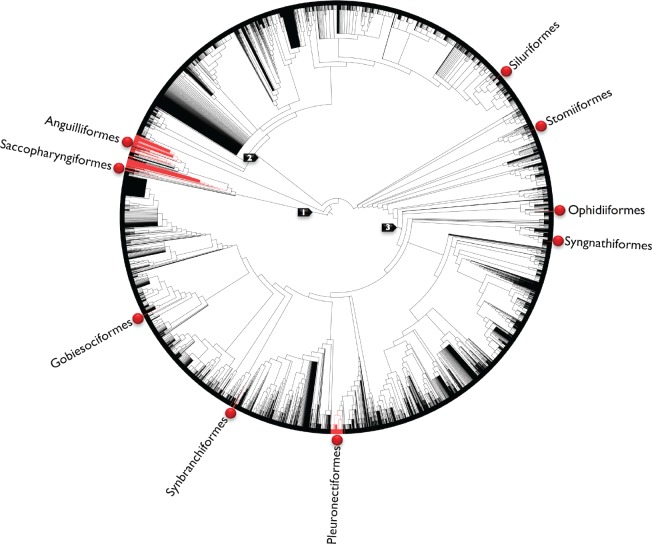
Visualization of pectoral fin presence (black) and absence (red) across 38,419 species of teleost fishes using an unordered parsimony method of reconstruction requiring 27 steps. Fin loss is evident in nine orders (red balls). Arrows indicate higher-level groupings: 1 \documentclass[12pt]{minimal}
\usepackage{amsmath}
\usepackage{wasysym}
\usepackage{amsfonts}
\usepackage{amssymb}
\usepackage{amsbsy}
\usepackage{upgreek}
\usepackage{mathrsfs}
\setlength{\oddsidemargin}{-69pt}
\begin{document}
}{}$=$\end{document} Elopomorpha; 2 \documentclass[12pt]{minimal}
\usepackage{amsmath}
\usepackage{wasysym}
\usepackage{amsfonts}
\usepackage{amssymb}
\usepackage{amsbsy}
\usepackage{upgreek}
\usepackage{mathrsfs}
\setlength{\oddsidemargin}{-69pt}
\begin{document}
}{}$=$\end{document} Otomorpha; 3 \documentclass[12pt]{minimal}
\usepackage{amsmath}
\usepackage{wasysym}
\usepackage{amsfonts}
\usepackage{amssymb}
\usepackage{amsbsy}
\usepackage{upgreek}
\usepackage{mathrsfs}
\setlength{\oddsidemargin}{-69pt}
\begin{document}
}{}$=$\end{document} Percomorphaceae.